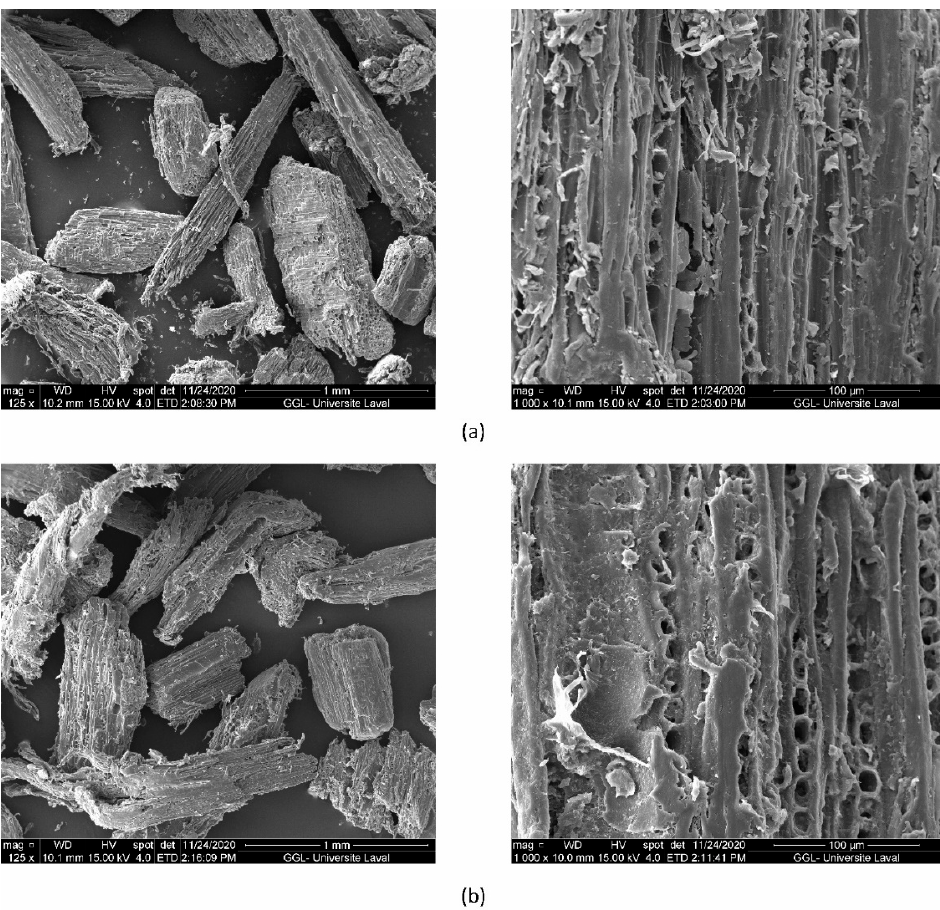
Figure 5. Surface of the maple fibers at 125 × (left) and 1000 × (right) magnification: ( a ) untreated and ( b ) treated.